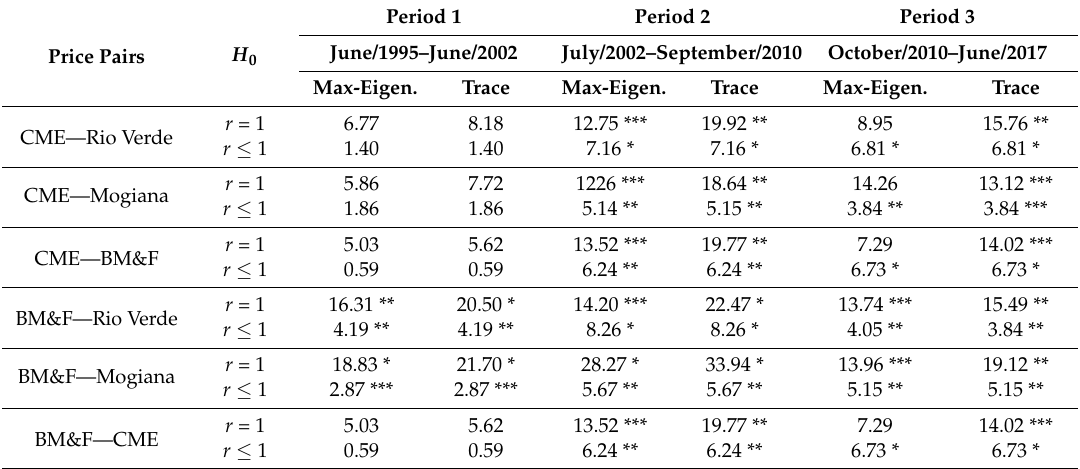
Table A3. Johansen tests for co-integration between corn price pairs.